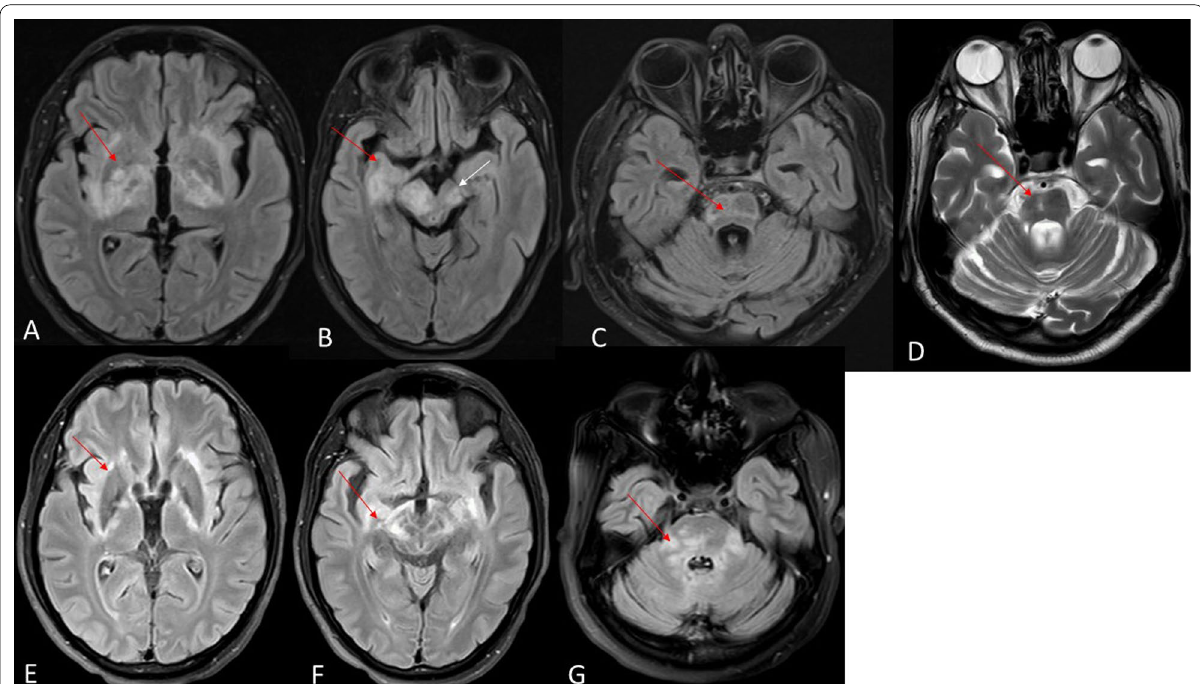
Fig. 2 MRI brain of patient 6 ( A , B , E , F ). A , B axial FLAIR images show hyperintense lesion in bilateral basal ganglia, right medial temporal lobe and midbrain (red and white arrows); E , F axial FLAIR images showing decrease in lesion with treatment; C , D axial FLAIR and T 2 images of patient 8 showing pontine hyperintense lesion with ponto-cerebellar atrophy (red arrows); axial FLAIR images of patient 9 showing pontine, bilateral middle cerebellar peduncles and cerebellar lesion (red